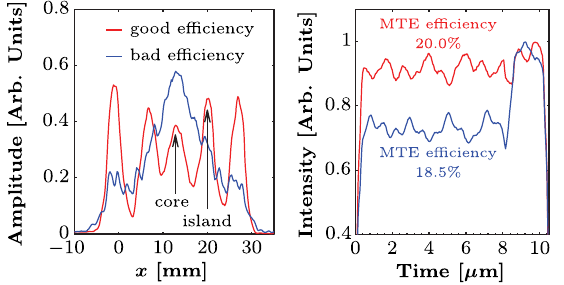
FIG. 7. Left: Measured horizontal beam distribution for differ- ent efficiency of the beam splitting. Right: Corresponding intensity profile measured by a beam current transformer in the transfer line between the PS and the